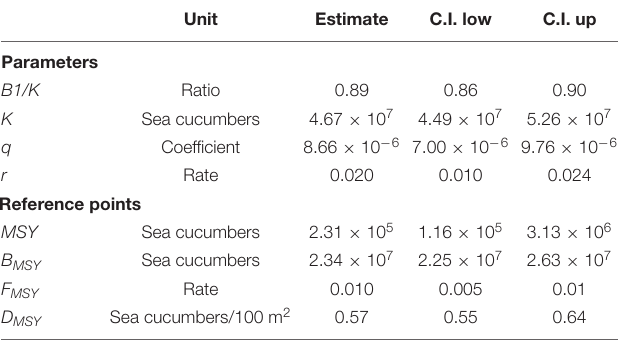
TABLE 1 | Parameters and reference points estimated for I. fuscus in the GMR. Unit